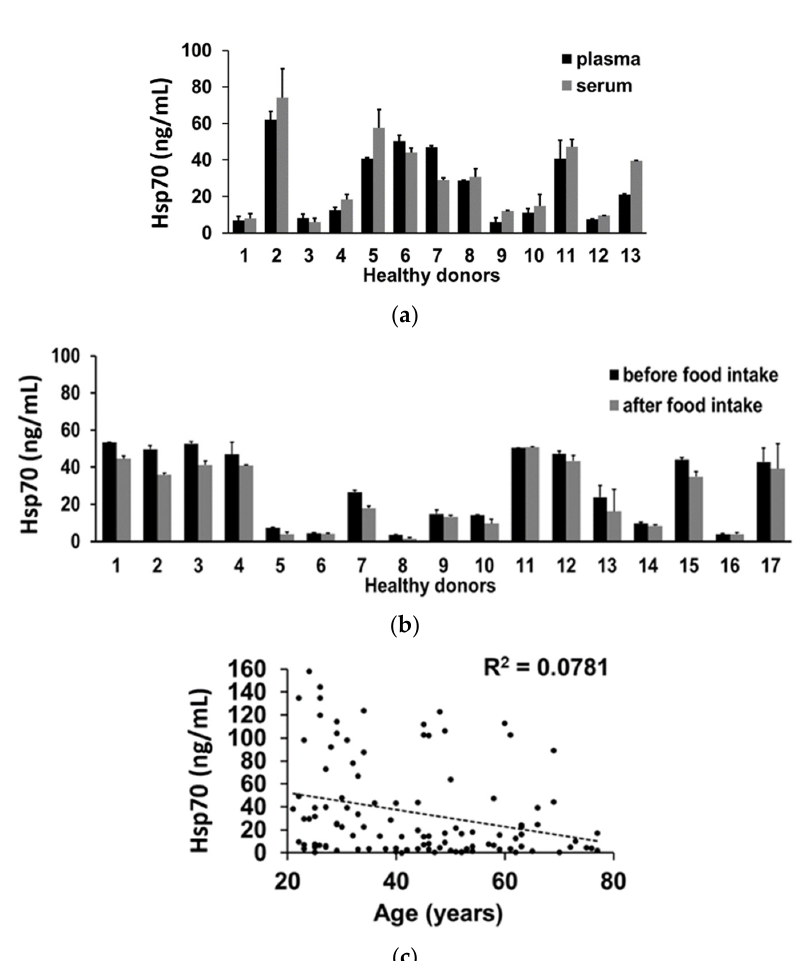
Figure 5. Interference factors potentially influencing the Hsp70 concentrations measured by the compHsp70 ELISA. ( a ) Comparison of the Hsp70 concentrations in plasma and serum. Plasma (black bars) and serum (grey bars) from 13 healthy individuals were taken at the same time. ( b ) Hsp70 concentrations in the serum of 17 healthy individuals taken before (black bars) and 2 h after a high fat diet (grey bars). ( c ) Hsp70 concentration of 108 healthy volunteers in different age groups ranging from 21–77 years. Characteristics of the healthy donors are summarized in Table 3. A Pearson correlation test was performed.